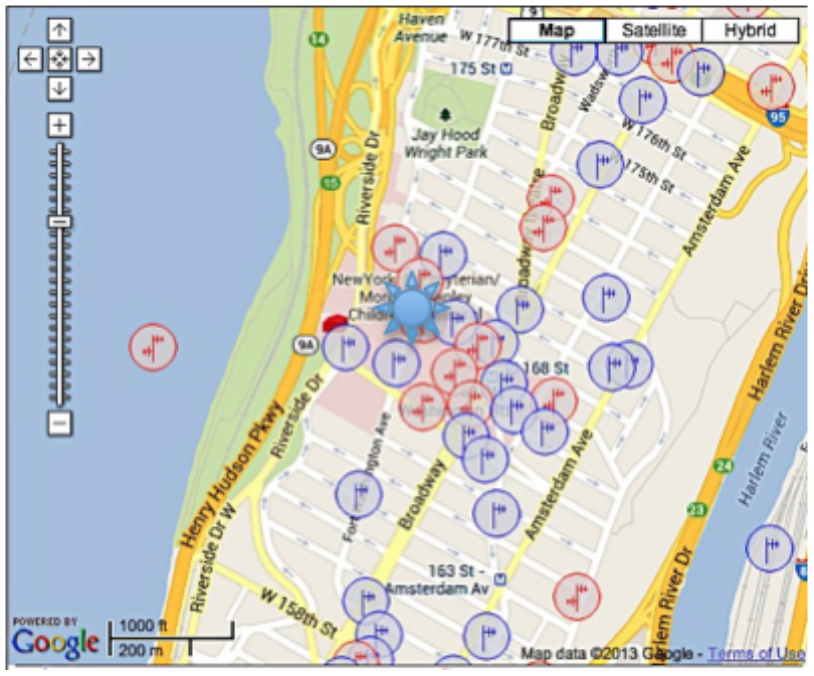
Figure 2. Antenna sites: 1050 Riverside Dr, New York, NY 10032. [Magnification